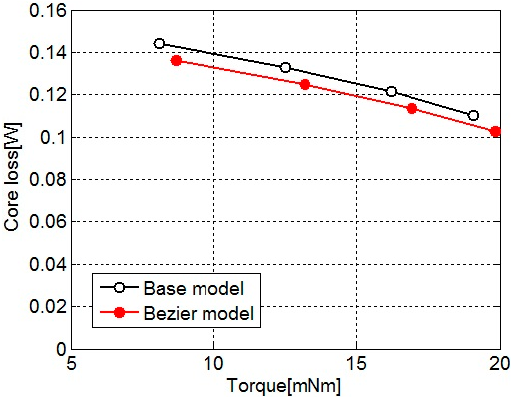
Figure 7. Core loss for torque of the base model and Bezier model.